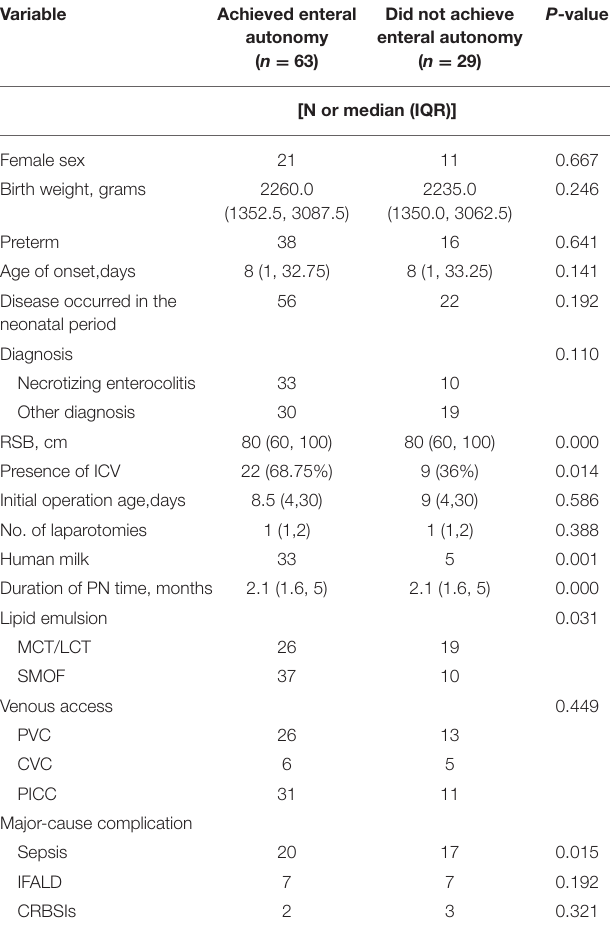
TABLE 3 | Baseline characteristics based on the primary outcome of achievement of enteral autonomy in children with intestinal failure.